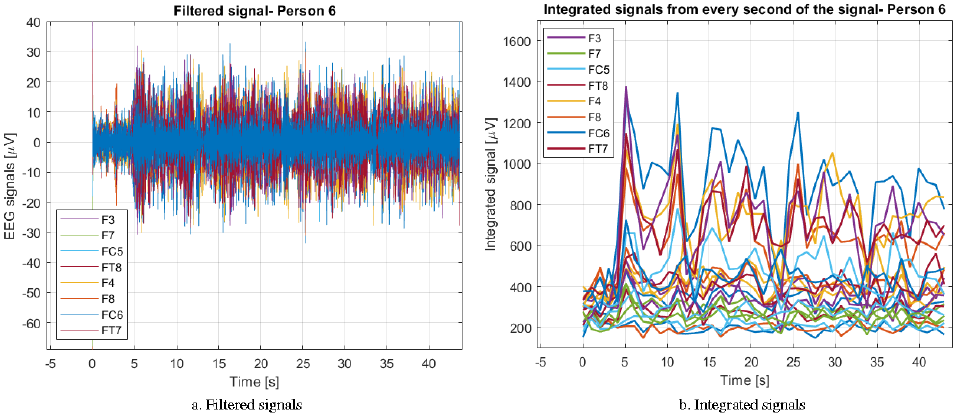
Figure 10. Comparison of filtered and integrated signals—Person 5.